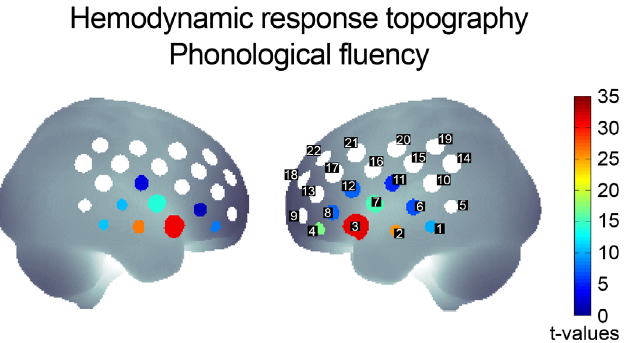
Fig 1. Topography of significantly increased hemodynamic responses during phonological fluency compared to the control condition (FDR-corrected) in the total sample. Channel numbers of the left hemisphere correspond to contralateral channel